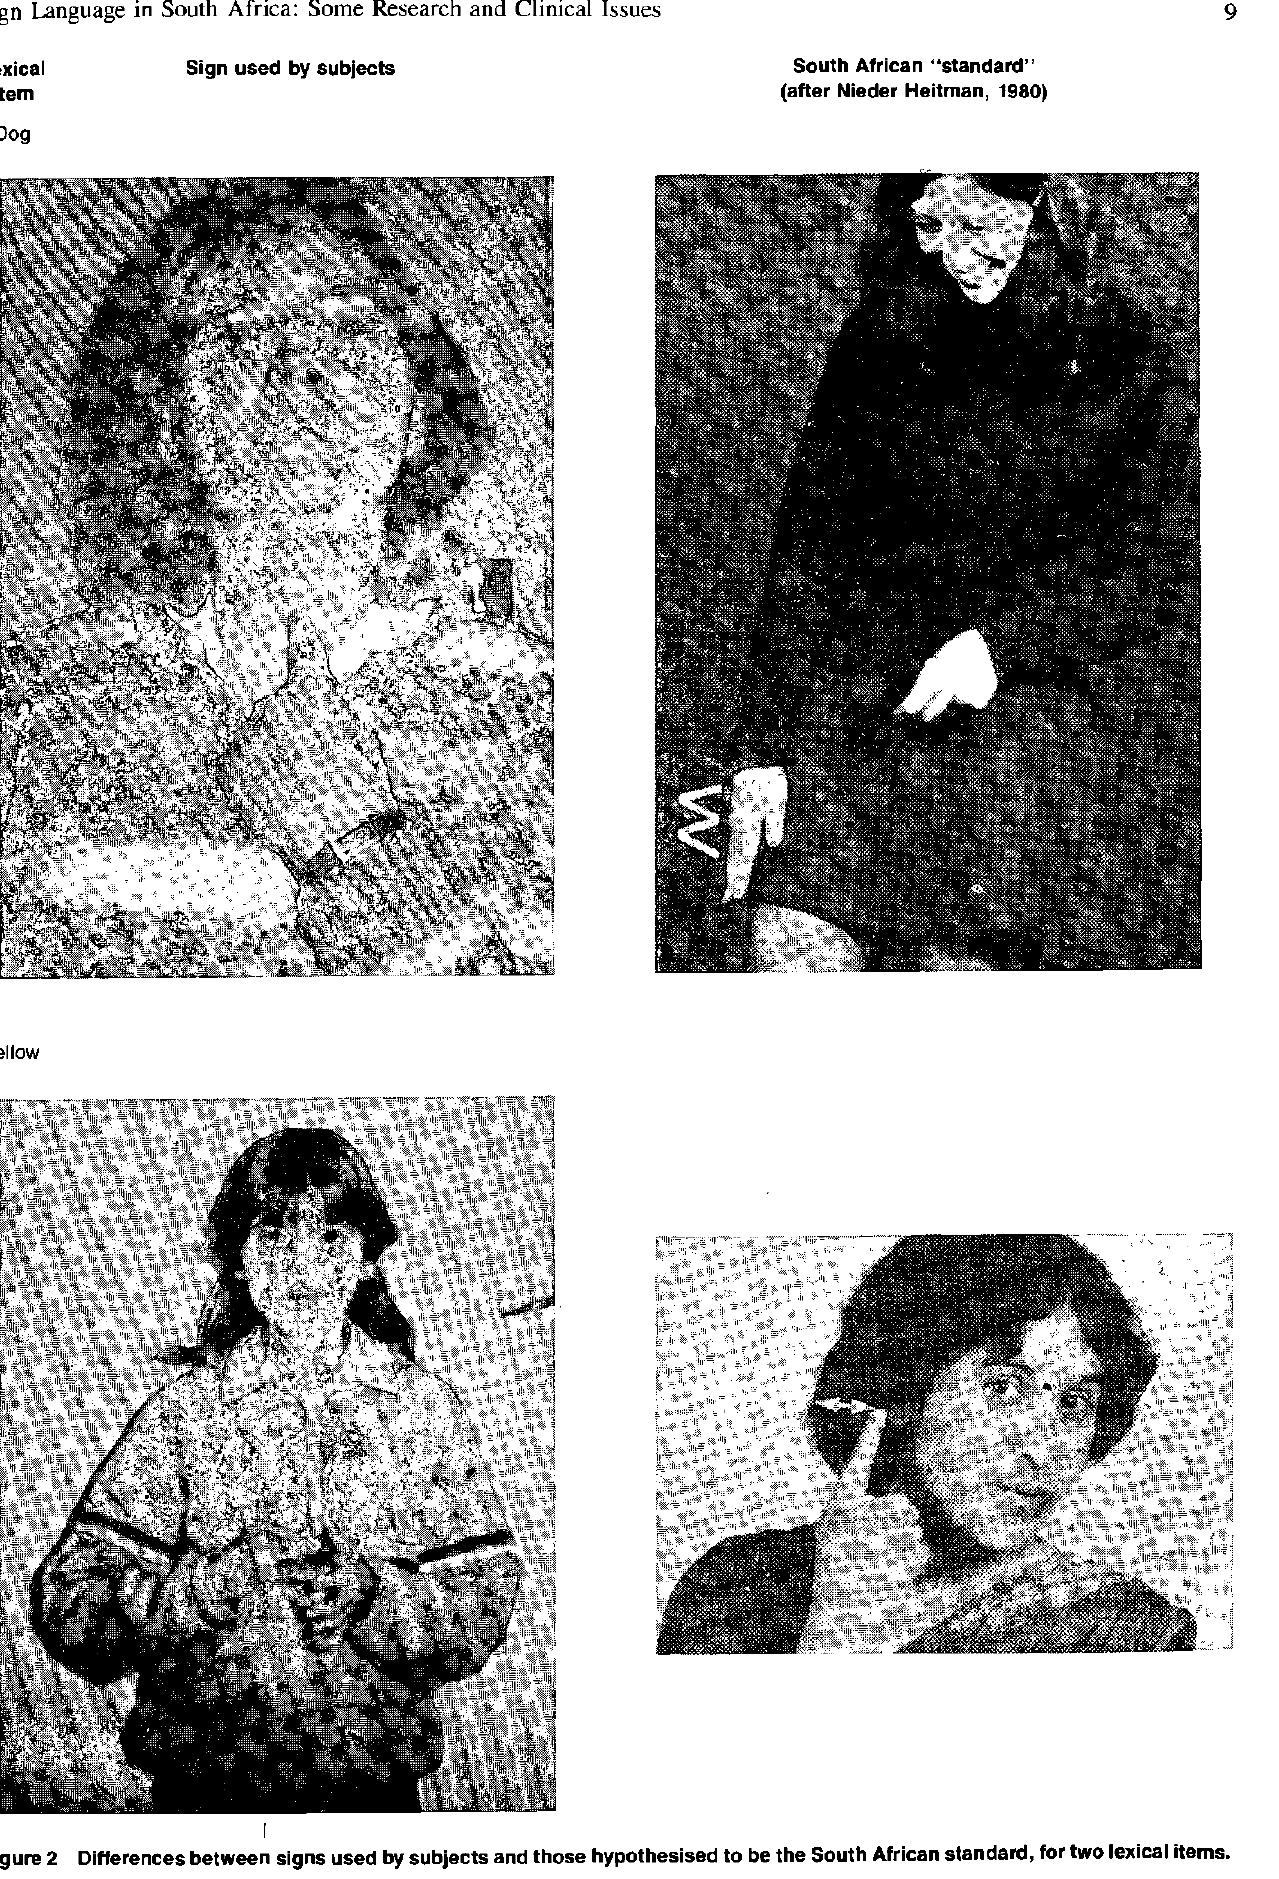
Figure 2 Differences between signs used by subjects and those hypothesised to be the South African standard, for two lexical items. Die Suid-Afrikaanse Tydskrif vir Kommunikasieafwykings, Vol. 31,